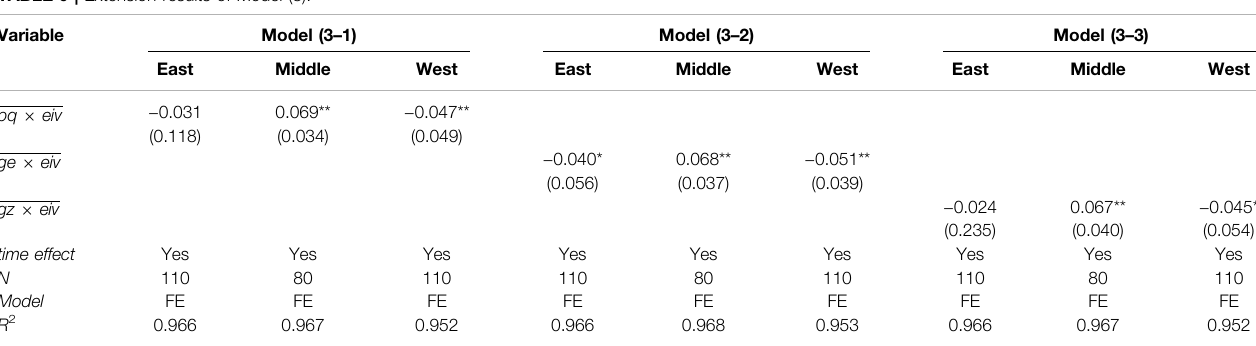
TABLE 9 | Extension results of Model (3).